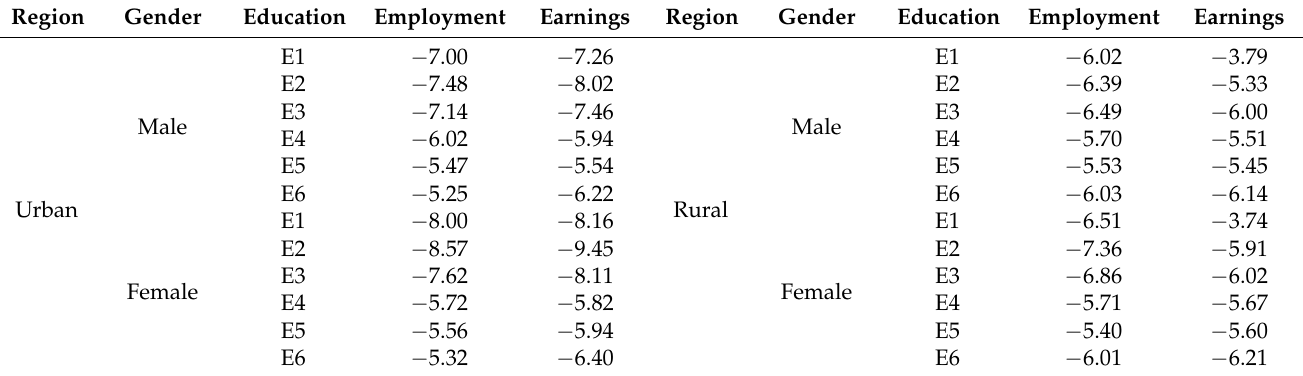
Table 1. The impact of the COVID-19 pandemic on employment and earnings by labourer type (%). Region Gender Education